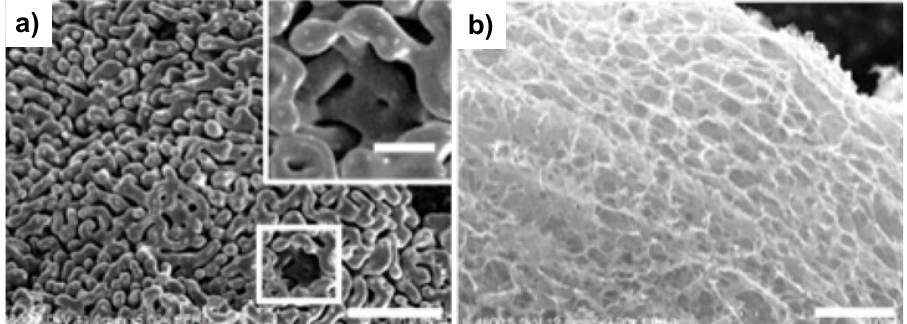
Figure 7. ( a ) SEM image of graphene layers deposited on the CaO surface; ( b ) SEM image of graphene foam with a layered structure. Scale bar for ( a ) is 5 µm, for inset in ( a ) is 2 µm, and for ( b ) is 10 µm. Reprinted with permission from ref. [14]. Copyright 2016 American Chemical Society.